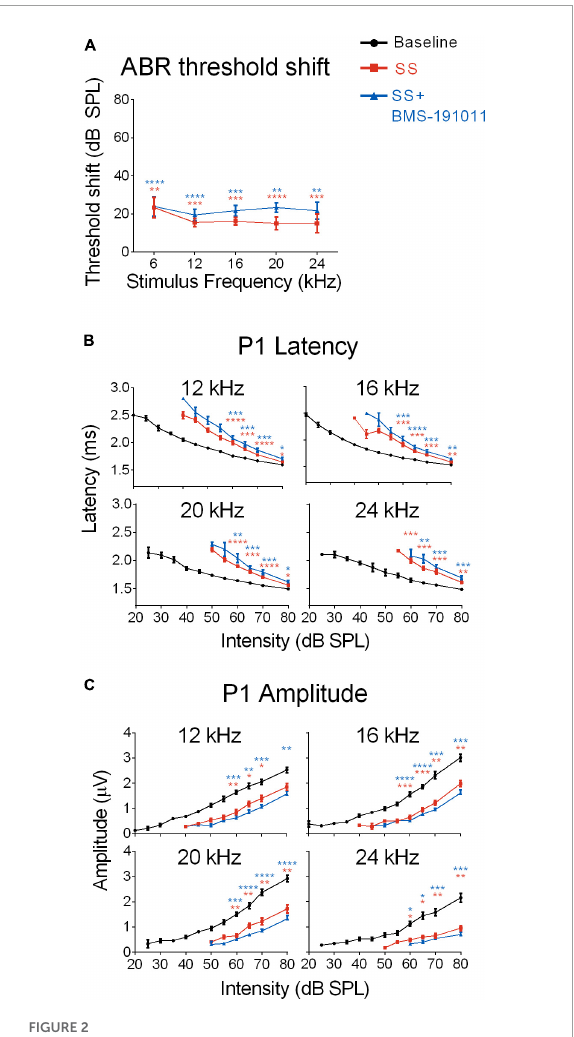
FIGURE2 BMS-190111 treatment does not effect SS-suppressed auditory nerve output. (A) ABR stimulus frequency ploted as a function of threshold shift relative to baseline for post-SS and post- SS + BMS. A two-way RM ANOVA of threshold shifts showed a main effect of treatment ( F (1.233,9.866) = 38.98; p < 0.0001) and frequency ( F (1.681,13.45) = 52.26; p < 0.0001) when SS (orange) and SS + BMS-191011 (blue) groups were included. Post-hoc analyses showed that thresholds increased relative to baseline following SS administration, but were not further altered by BMS-191011 treatment. Orange and blue asterisks indicate a significant difference from baseline for the SS and SS + BMS-191011 groups, respectively. (B) Plots show the quantification of P1 latencies as a function of intensity for 12, 16, 20 and 24 kHz tone bursts at baseline (black), post-SS (orange) and post-SS + BMS (blue). Two-way RM ANOVAs indicated